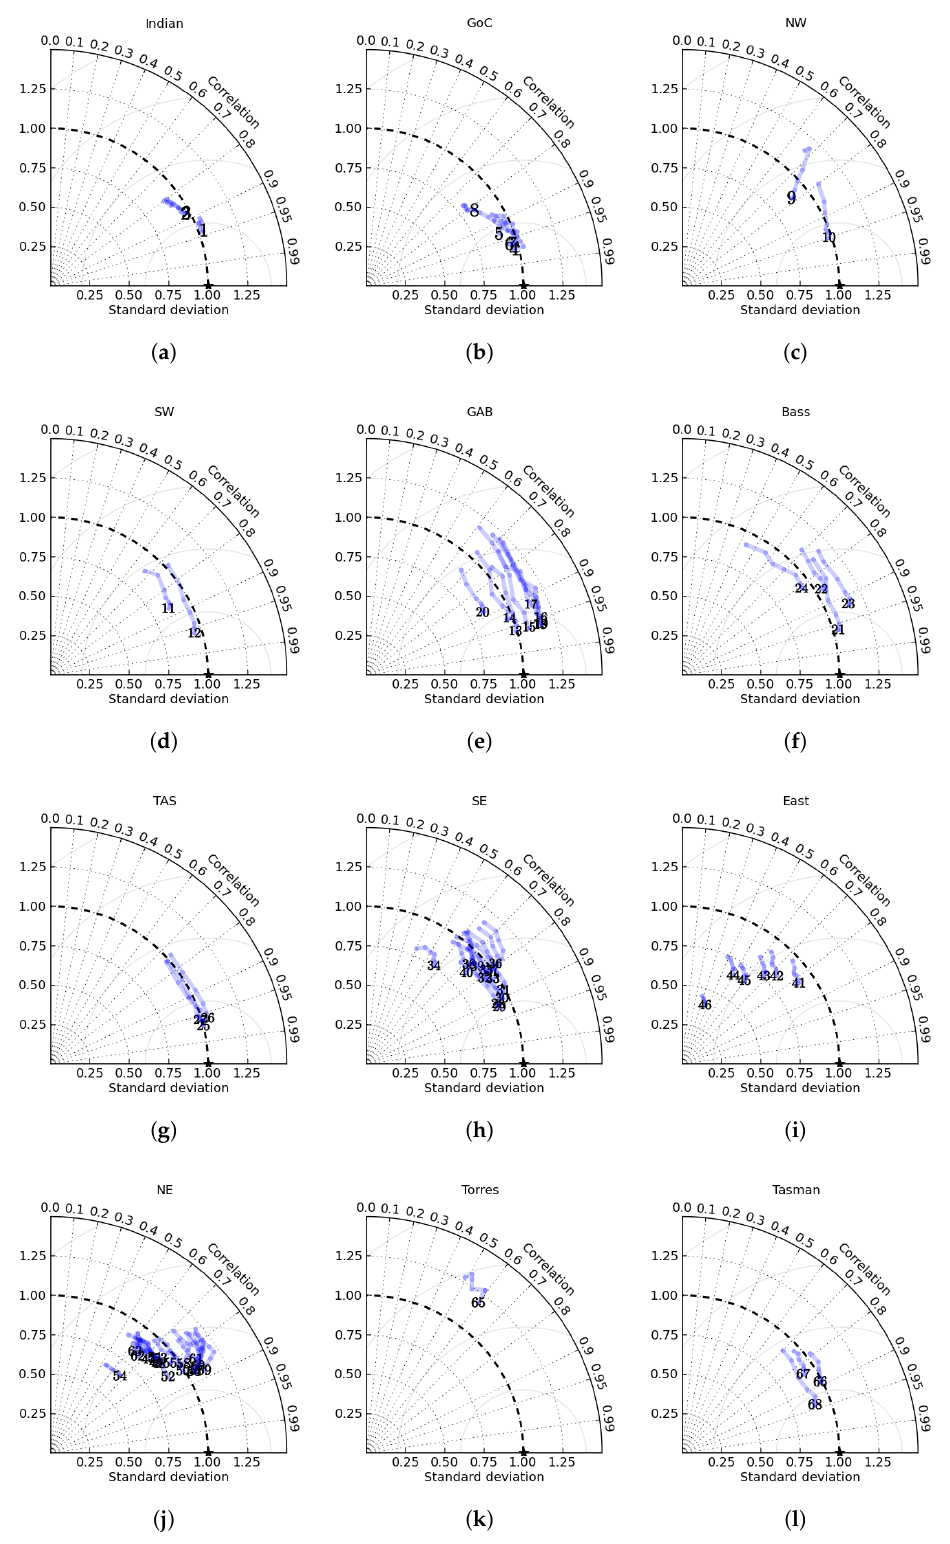
Figure 8. Taylor diagrams summarising dynamic skill evolution across 7-day forecasts. Each ‘comet’ describes average statistics for one location. Panels are divided according to regions shown in Figure 4. Statistics are derived from filtered time series, not total sea level, and are normalised relative to the reference observations. ( a ) Indian; ( b ) Gulf of Carpentaria; ( c ) North West; ( d ) South West; ( e ) Great Aust Bight; ( f ) Bass Strait; ( g ) Tasmania; ( h ) South East; ( i ) East; ( j ) North East; ( k ) Torres Stait; ( l ) Tasman